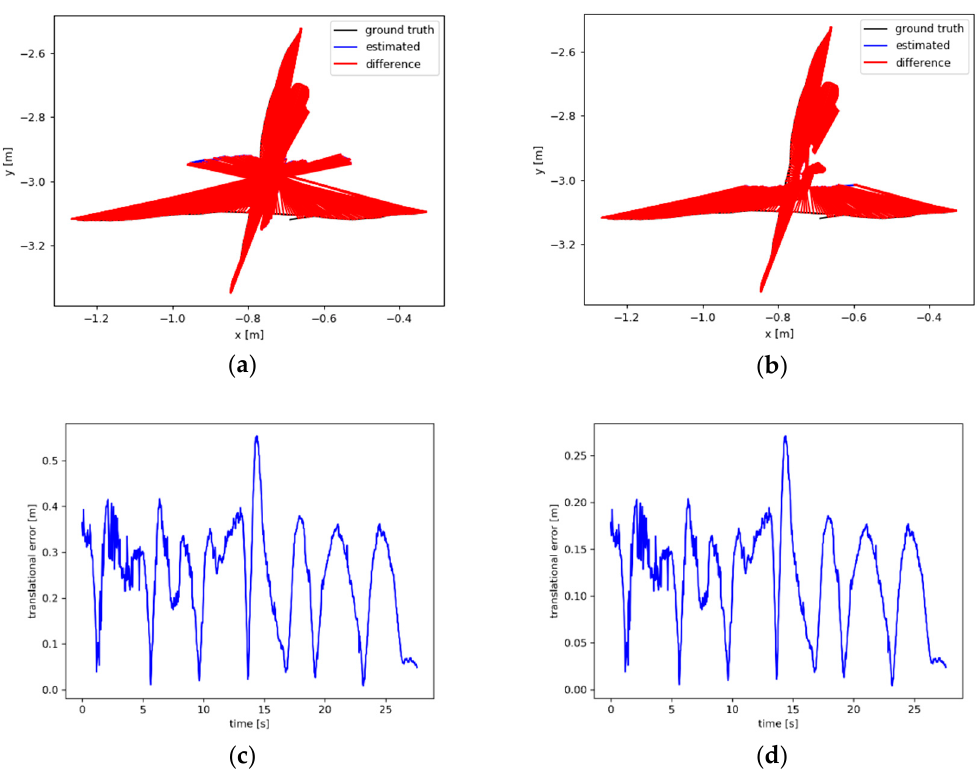
Figure 7. ( a ) and ( c ) are ATE and RPE from ORB-SLAM2 respectively. ( b ) and ( d ) are ATE and results of metric rotational drift (RPE) from DM-SLAM, respectively.